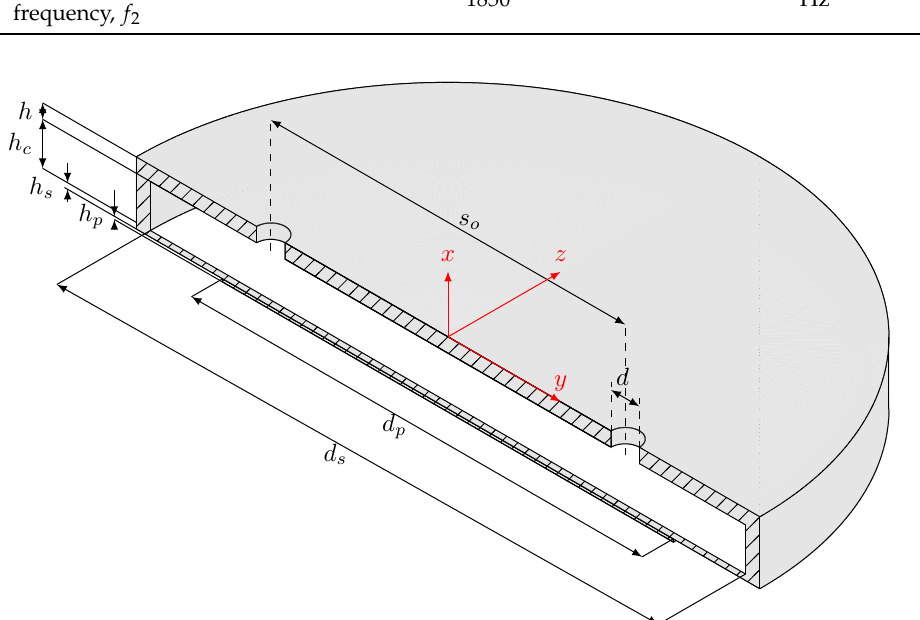
Figure 2. Sketch of the double-orifice configuration under investigation, with main notation and reference